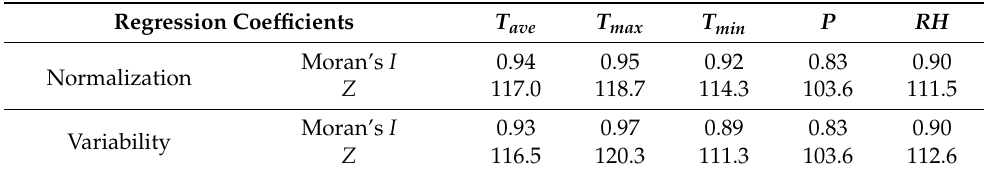
Table 2. Moran’s I and Z scores of regression coefficients for each factor in the geographically weighted regression model.